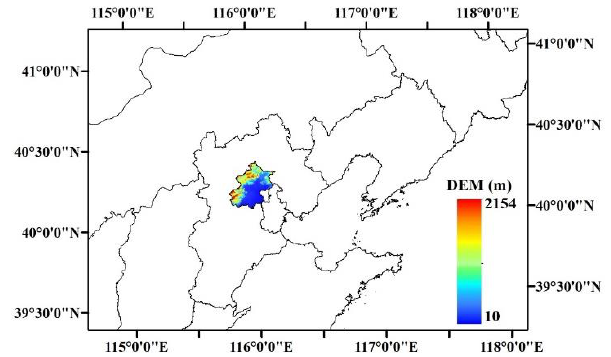
Figure 1. The location of